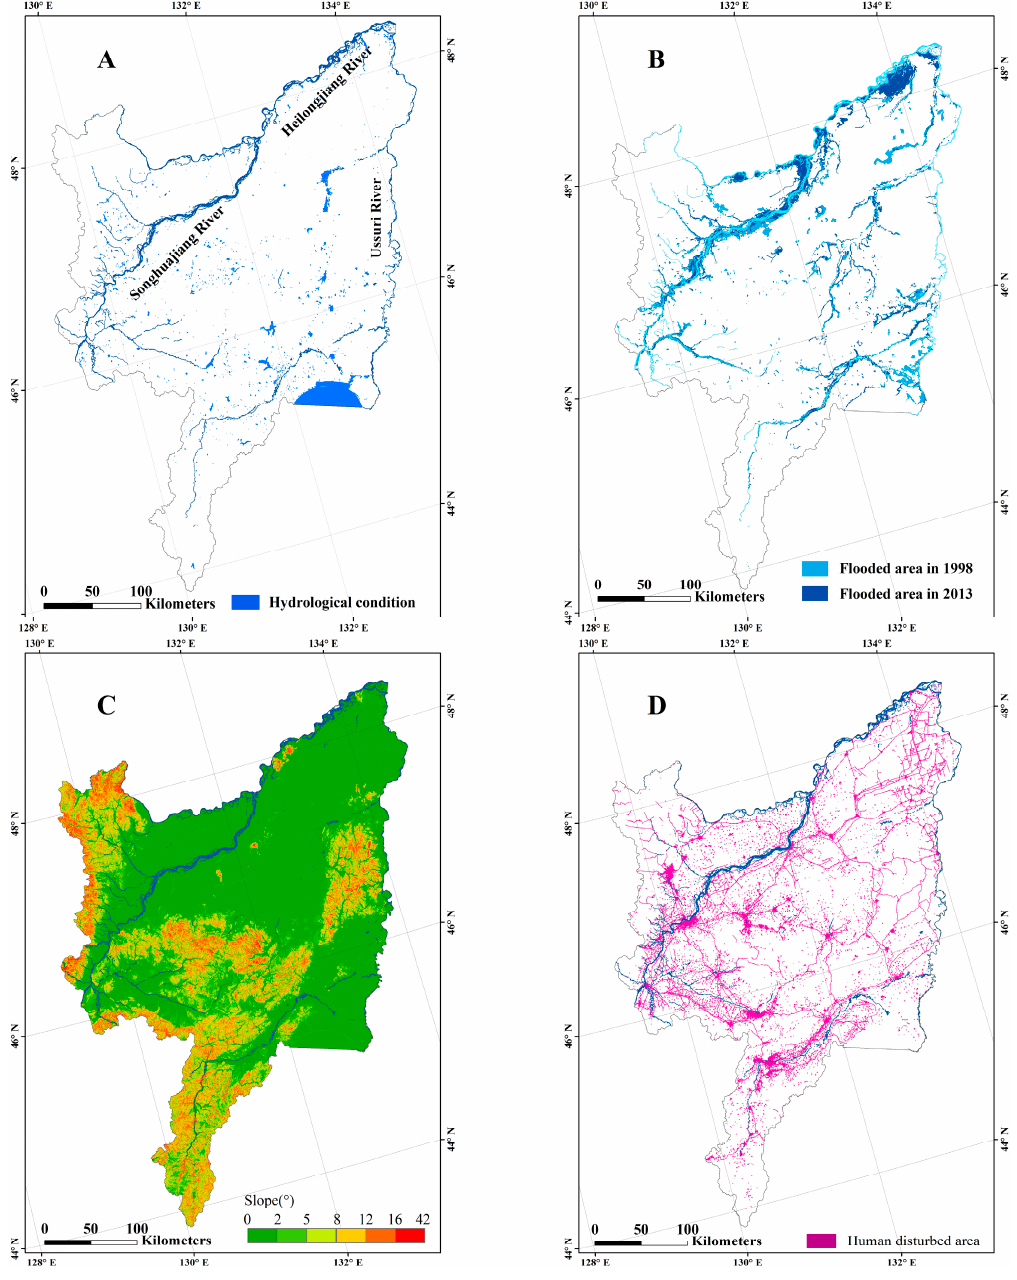
Figure 5. Spatial patterns of wetland rehabilitation indicators: ( A ) hydrological conditions in 2018; ( B ) the flooded areas in 1998 and 2013; ( C ) topographic slope; and ( D ) anthropogenic threats in 2018.